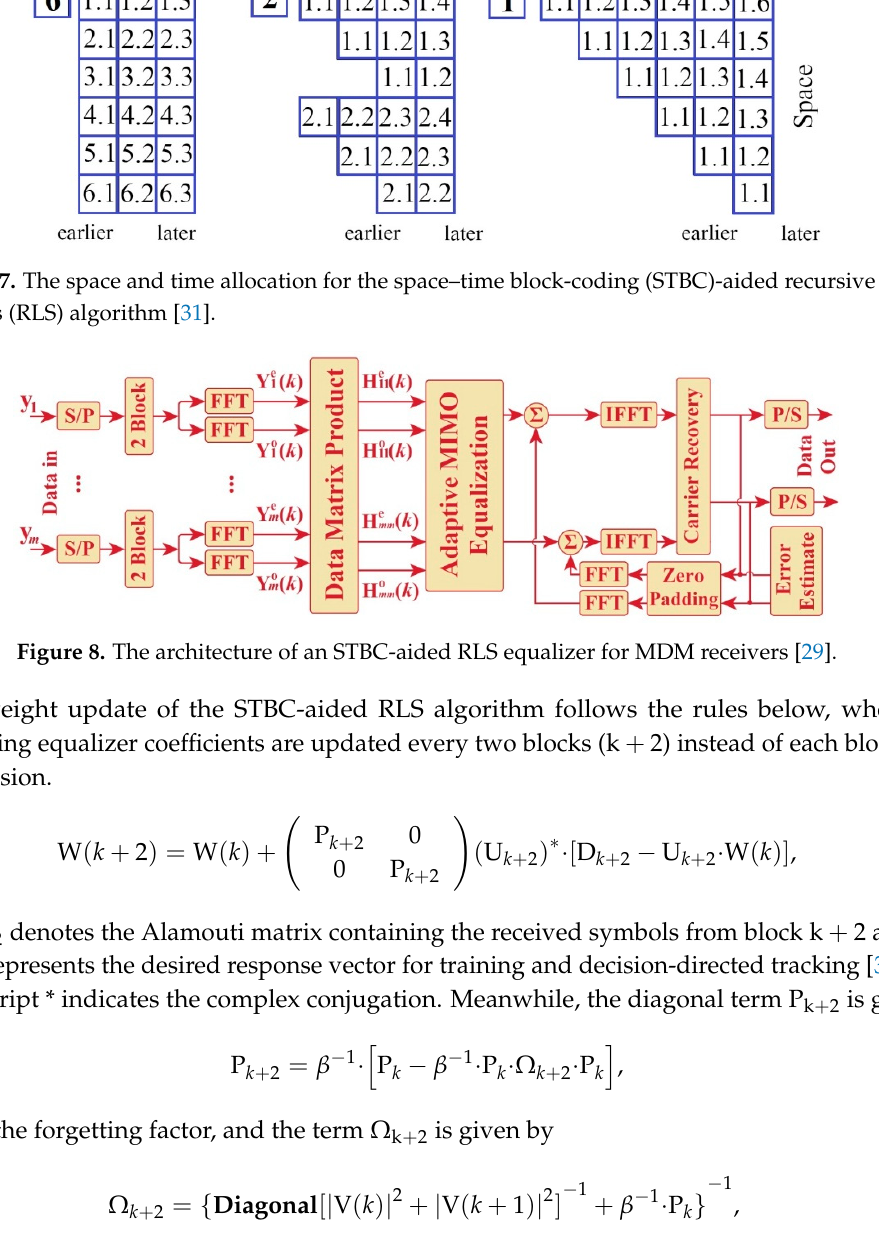
Figure 8. The architecture of an STBC-aided RLS equalizer for MDM receivers [29].